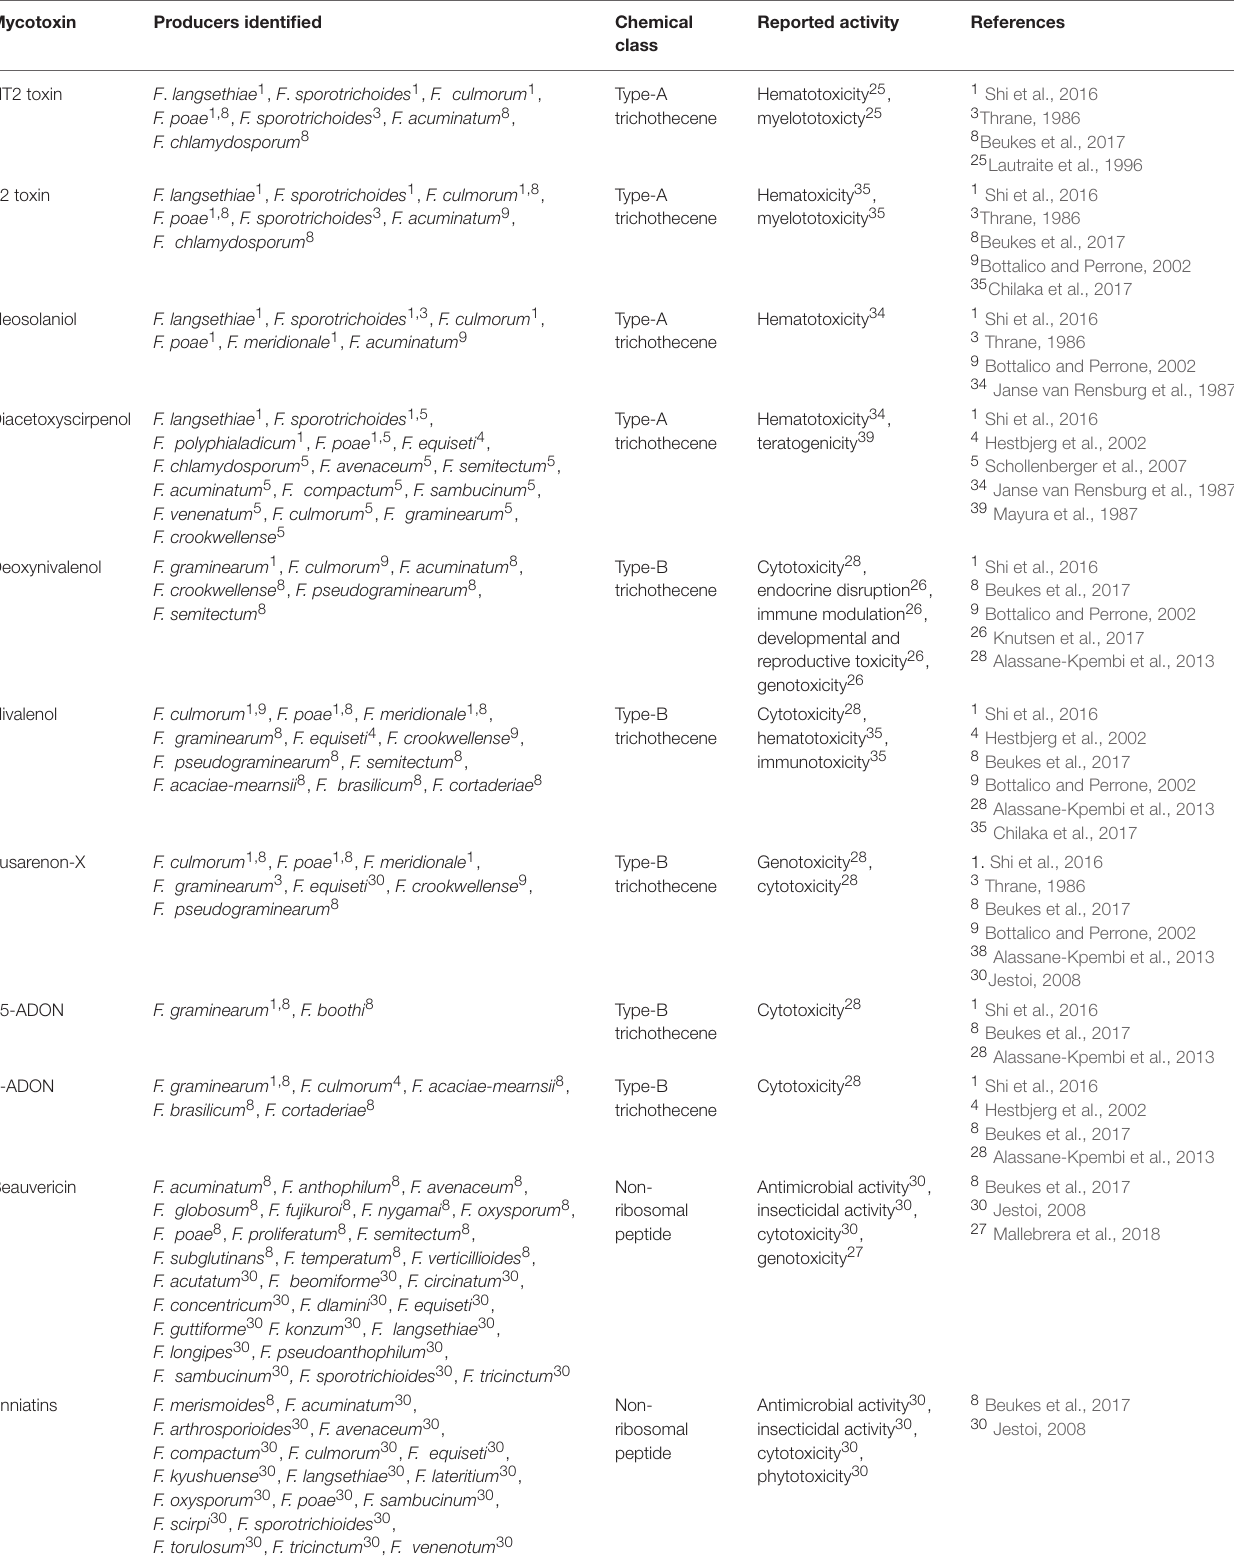
TABLE 1 | List of different mycotoxins and their chemical classes, the Fusarium species identified as producers of each mycotoxin, and corresponding reported